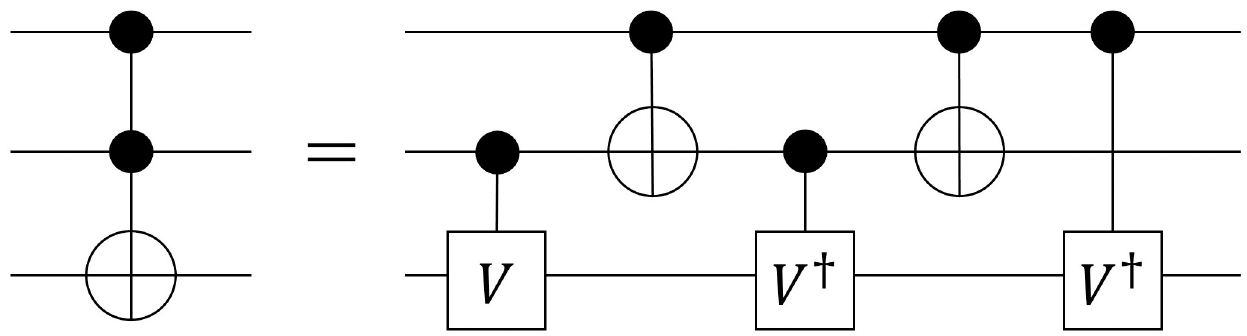
Fig 2. Toffoli gate implementation with basic quantum gates. A circuit composed of five basic quantum gates implementing the Toffoli gate C 2 NOT (1, 2;3).